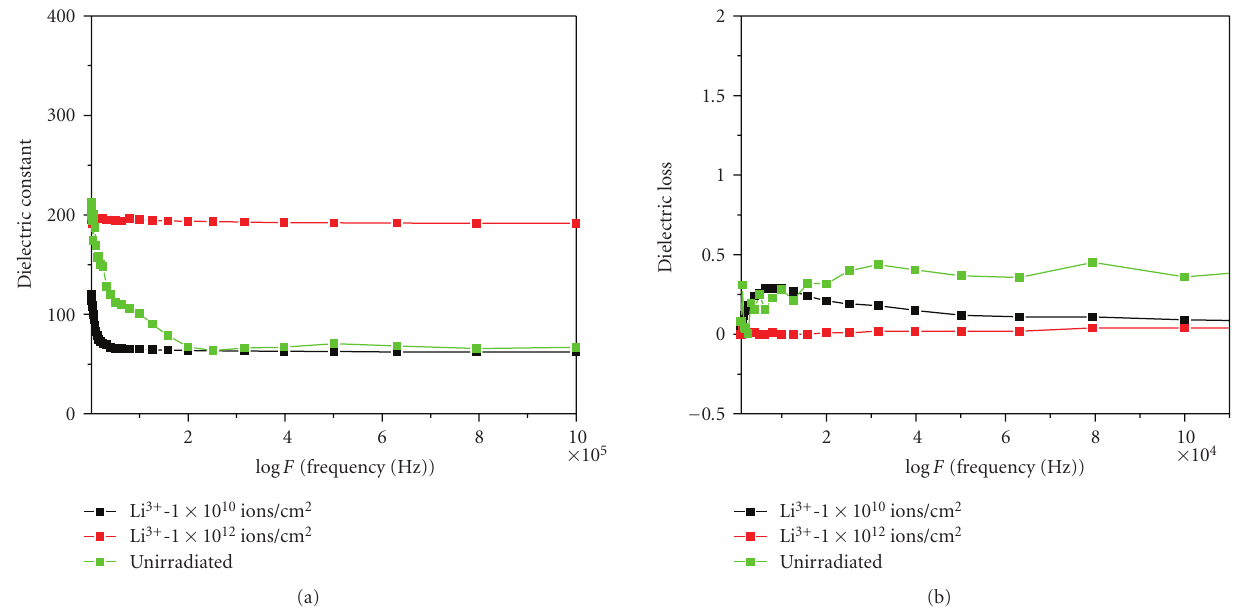
Figure 58: (a) Dielectric constant of unirradiated and irradiated L-threonine single crystals at various ion fluences. (b) dielectric loss of unirradiated and irradiated L-threonine single crystals at various ion fluencies. Linear and the second order nonlinear SHG suscep-